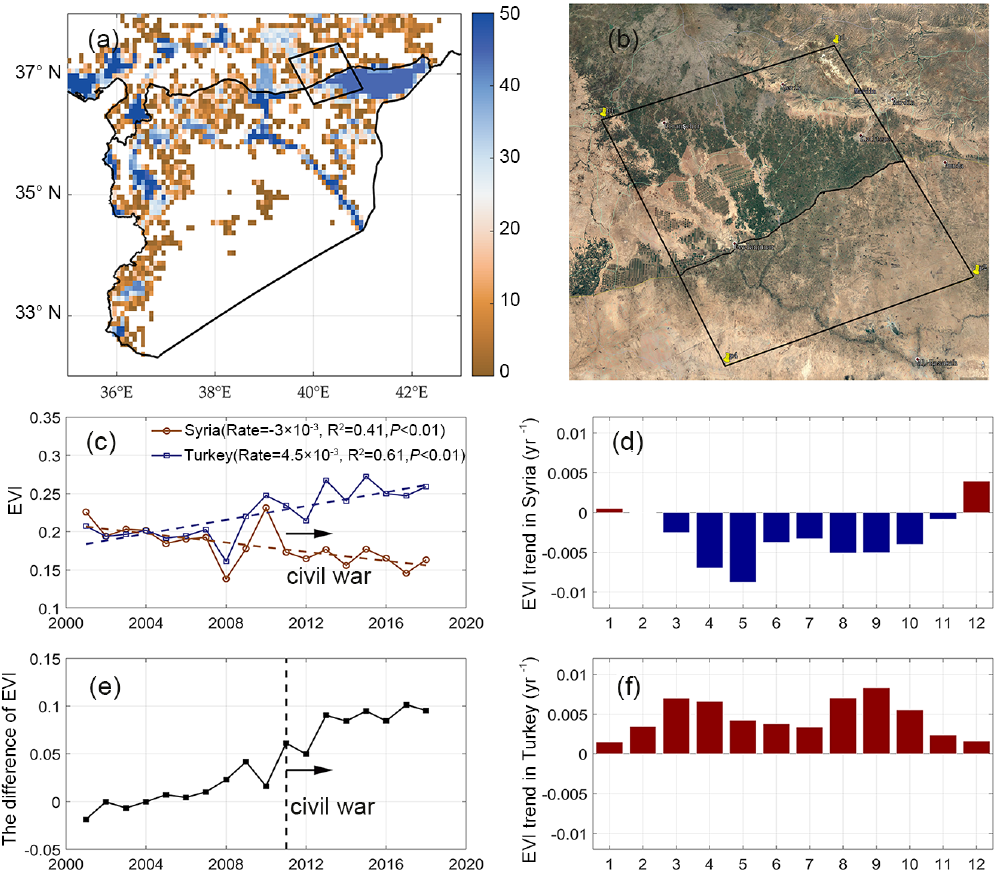
Figure 7. (a) The percentage of the total cropland area used for irrigation for the reference year of 2005. (b) The Khabur River basin and cropland distribution (© Google Earth 2019, a KML file is attached). The vertex coordinates of the parallelogram are [37.5 ◦ N, 40.5 ◦ E], [36.75 ◦ N, 41 ◦ E], [37.25 ◦ N, 39.5 ◦ E] and [36.5 ◦ N, 40 ◦ E]. (c) Annual EVI series of cropland on the Syrian side and the Turkish side with linear fitting. (d) EVI trends of each month of cropland on the Syrian side. (e) EVI difference between the Turkish and Syrian sides of the basin (Turkey’s EVI minus Syria’s EVI). (f) EVI trends of each month of cropland on the Turkish